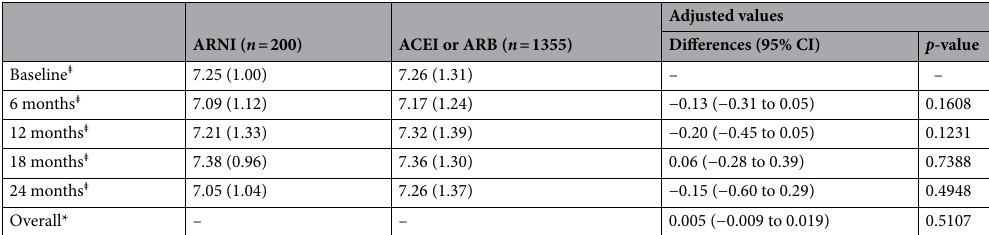
Table 2. HbA 1c concentrations (%) in the subjects from the treatment groups over the four time points. Data are expressed as the mean (SD). Number of patients with measurements of HbA 1c at the baseline for ‘ACEI or ARB’ and ‘ARNI’ = (1355 and 200), 6 months = (829 and 141), 12 months = (696 and 86), 18 months = (577 and 49), and 24-months = (505 and 27), respectively. Adjusted variable: stroke, insulin, calcium channel blocker (CCB), age, eGFR. ǂ Stepwise linear regression analysis. *Linear mixed model method.